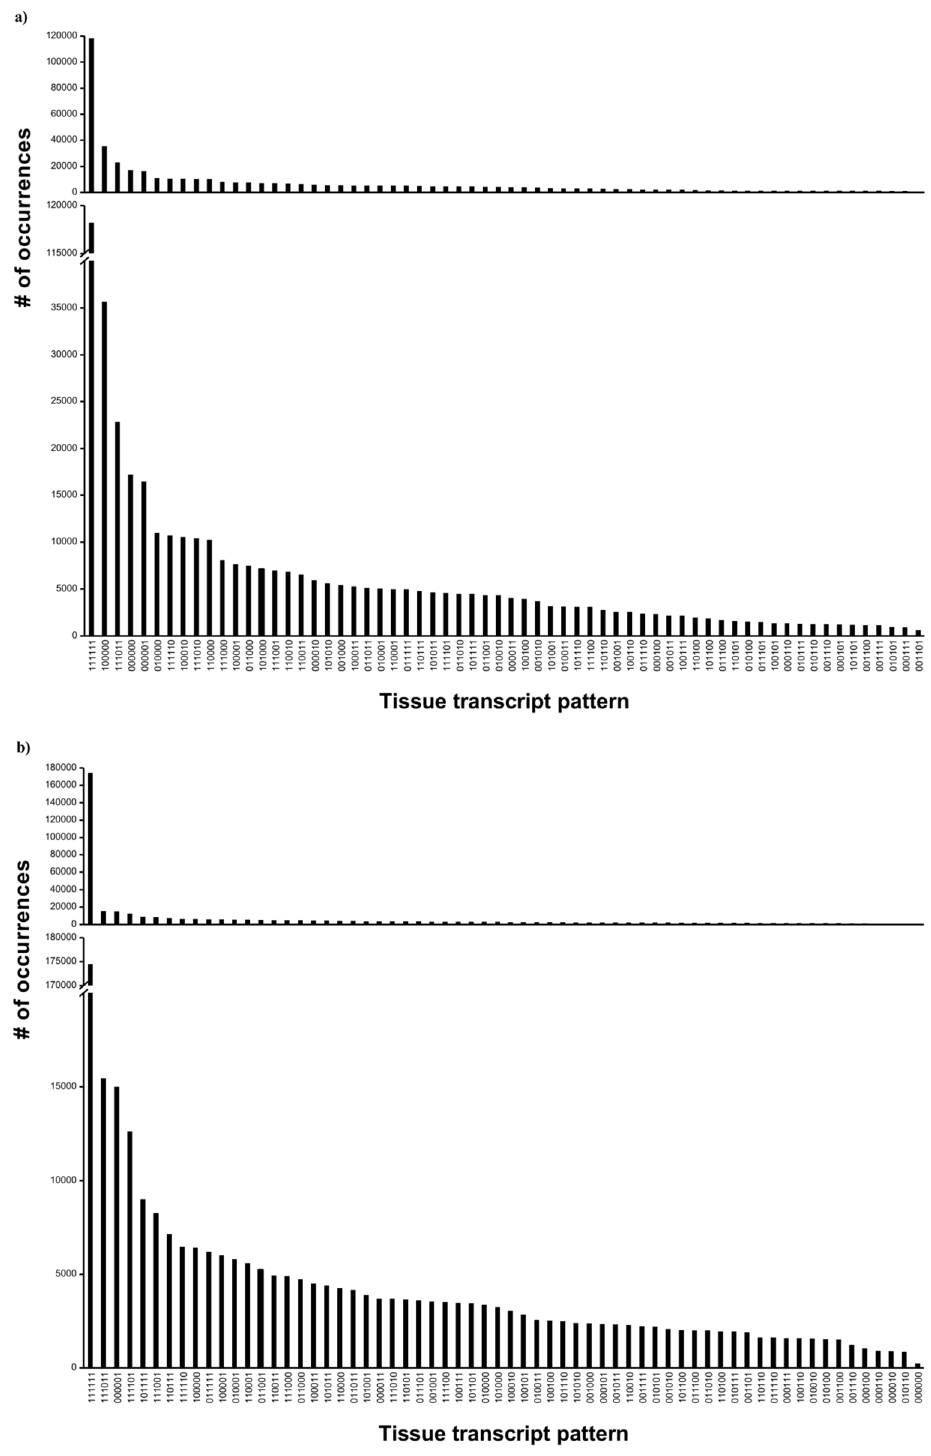
Fig 1. Transcript patterns across six different S . glomerata tissues. A) non-normalised and non-strand specific tissue reads were mapped to the combined reference transcriptome and b) strand-specific and normalised tissue reads were mapped to the strand-specific reference transcriptome, using CLC Workbench version 7.5. Graph shows the number of transcripts that are common across individual tissue patterns, with 1 standing for “ transcript present in tissue ” and 0 for “ transcript not present in tissue ” . The order in which